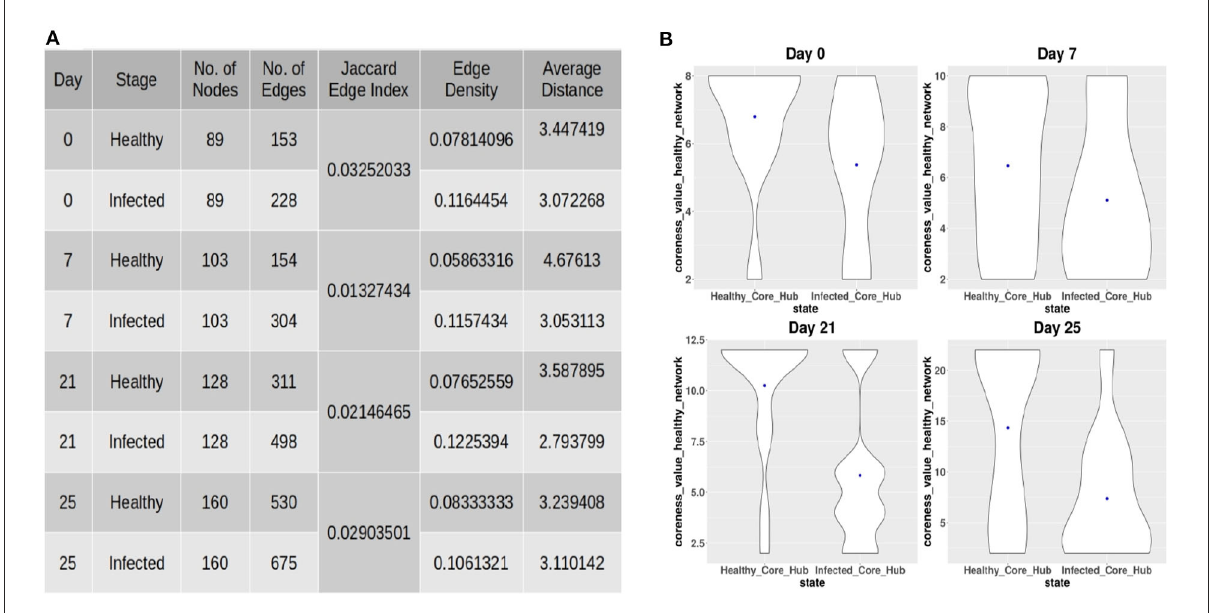
FIGURE2 (A) Topological properties of healthy and infected co-abundance networks at each of the time-points. (B) Coreness values of the ASVs belonging to the infected-core-hub community in the control network and the ASVs belonging to the control-core-hub